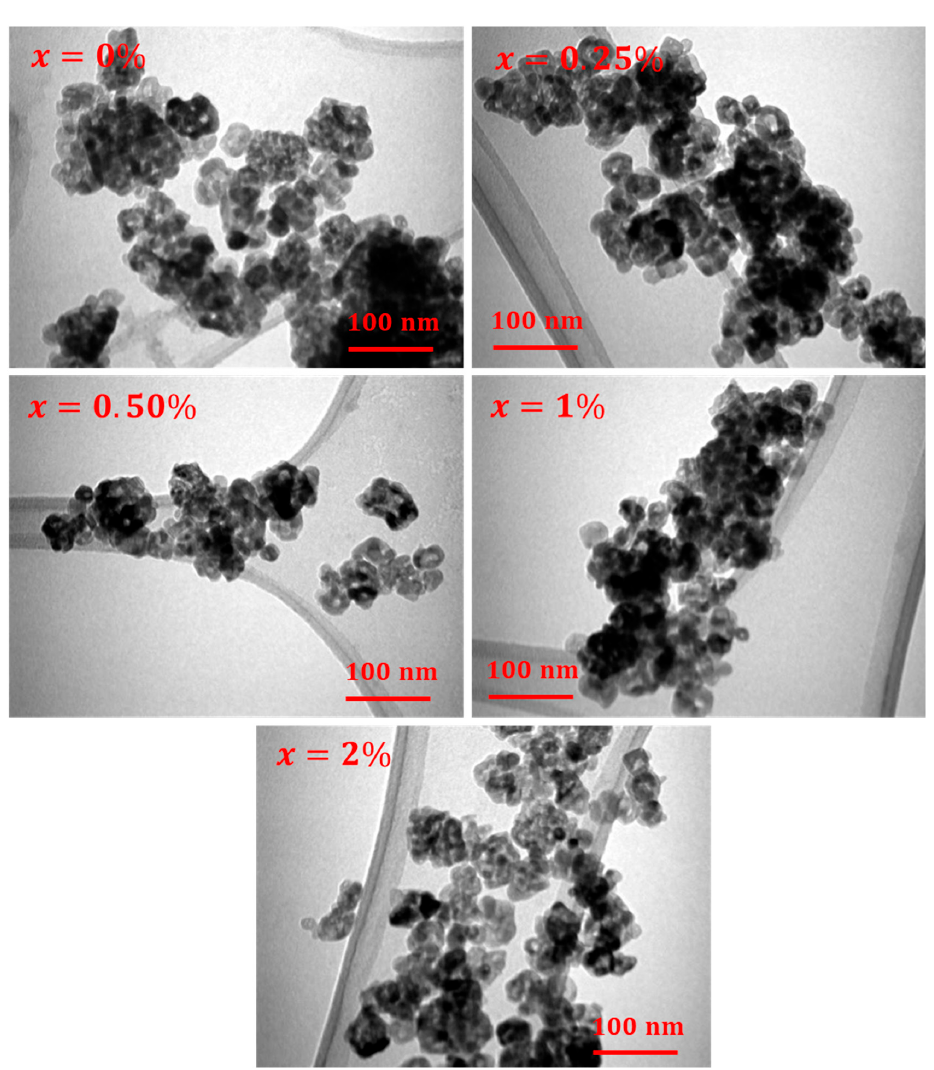
Figure 2. TEM images for Ce–Sm co-doped TiO 2 NPs ( x = 0, 0.25, 0.50, 1, and 2%).